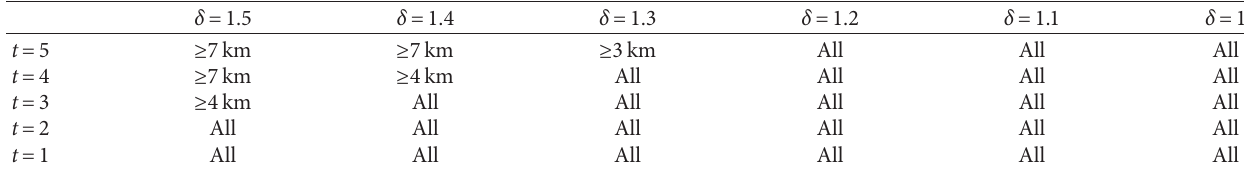
Figure 5: Difference in prospect value between drone delivery and rider delivery for different one-way pickup times. (a) Difference of prospect value when c � 1.3 and t � 5; (b) difference of prospect value when c � 1.3 and t � 4; (c) difference of prospect value when c � 1.3 and t � 3; (d) difference of prospect value when c � 1.3 and t � 2. Table 9: The delivery distance of drone superior to rider when c �